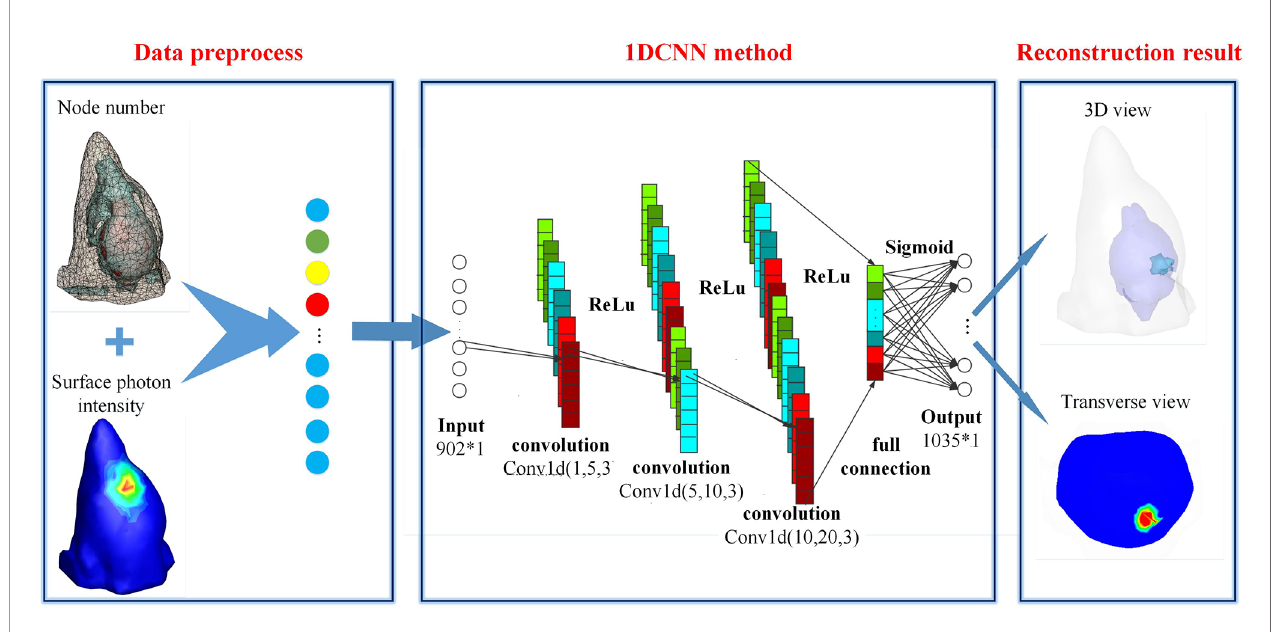
FIGURE 1 | The schematic diagram of 1DCNN used in BLT